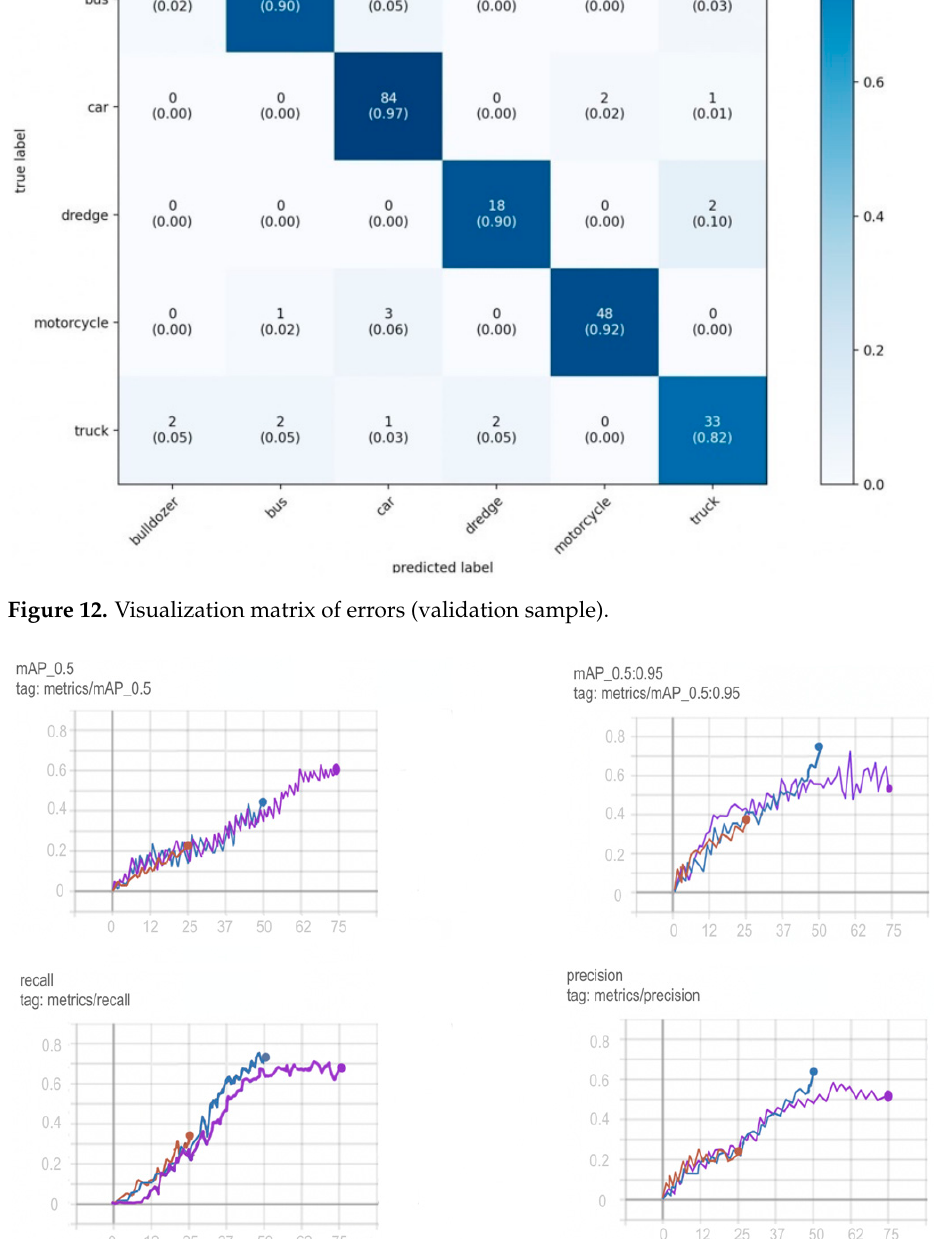
Figure 13. Comparison of training YOLOv5 at 25 (red graph), 50 (blue graph) and 75 (purple